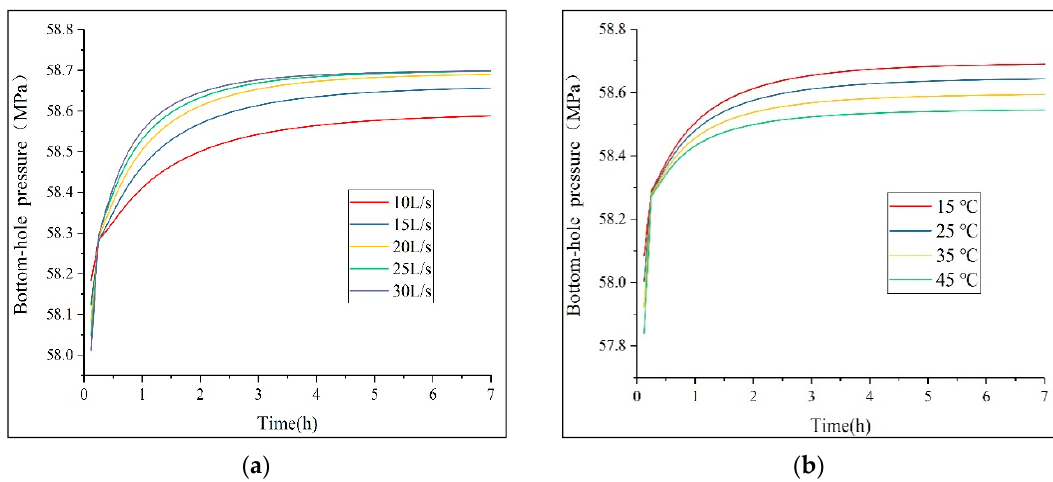
Figure 14. Variation of bottom-hole pressure at di ff erent pump rate and inlet temperature. ( a ) Variation of bottom-hole pressure at di ff erent pump rate; ( b ) Variation of bottom-hole pressure with di ff erent inlet temperature.